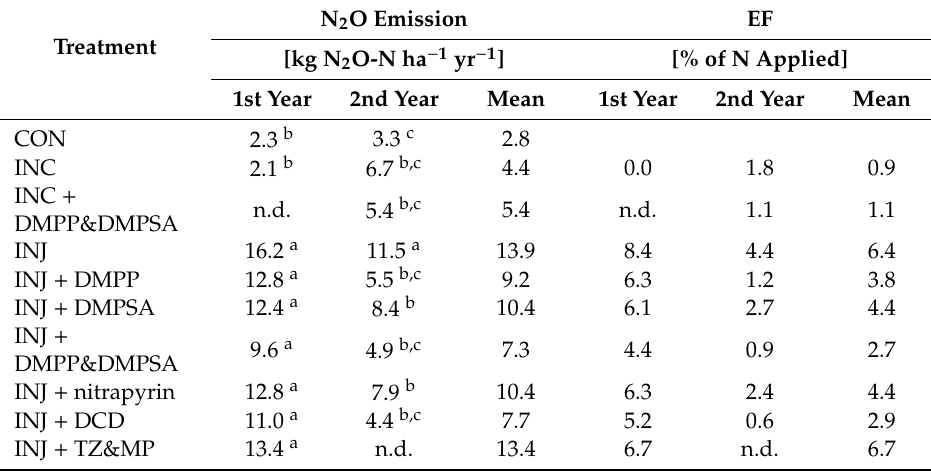
Table 2. Mean cumulative direct N 2 O emissions ( n = 4) as a ff ected by NI addition and application technique (injection (INJ), incorporation (INC)). The emission factors (EF) value indicates mean direct N 2 O emission. Di ff erent letters indicate statistically significant di ff erences between groups within the same year ( Student-Newman-Keuls test , p < 0.05). Direct N 2 O emission from unfertilized control (CON) indicate background emissions. The data from CON, INJ, and INC treatment were taken from Herr et al. [19]. For the treatment abbreviations we refer to Table